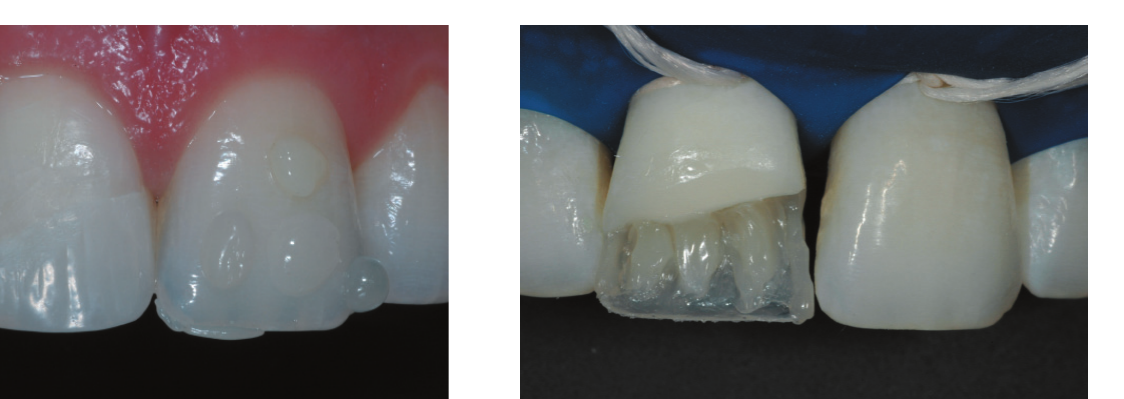
Figure 6- Reproduction of the deepest artificial dentin with more opaque characteristics